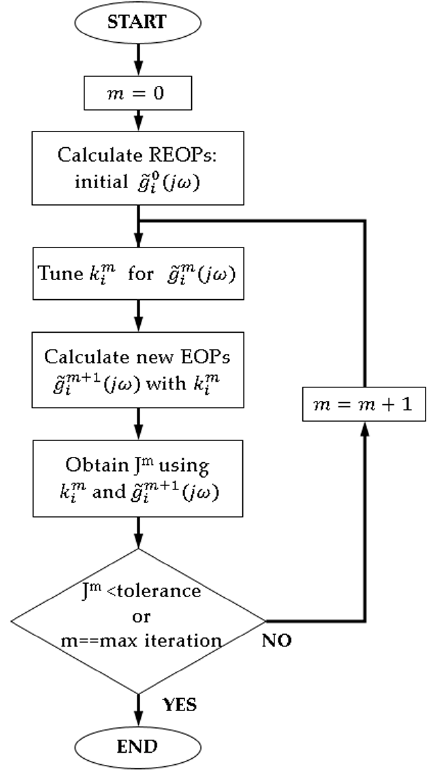
Figure 4. Flow diagram of the proposed algorithm for tuning multiloop PID controllers.